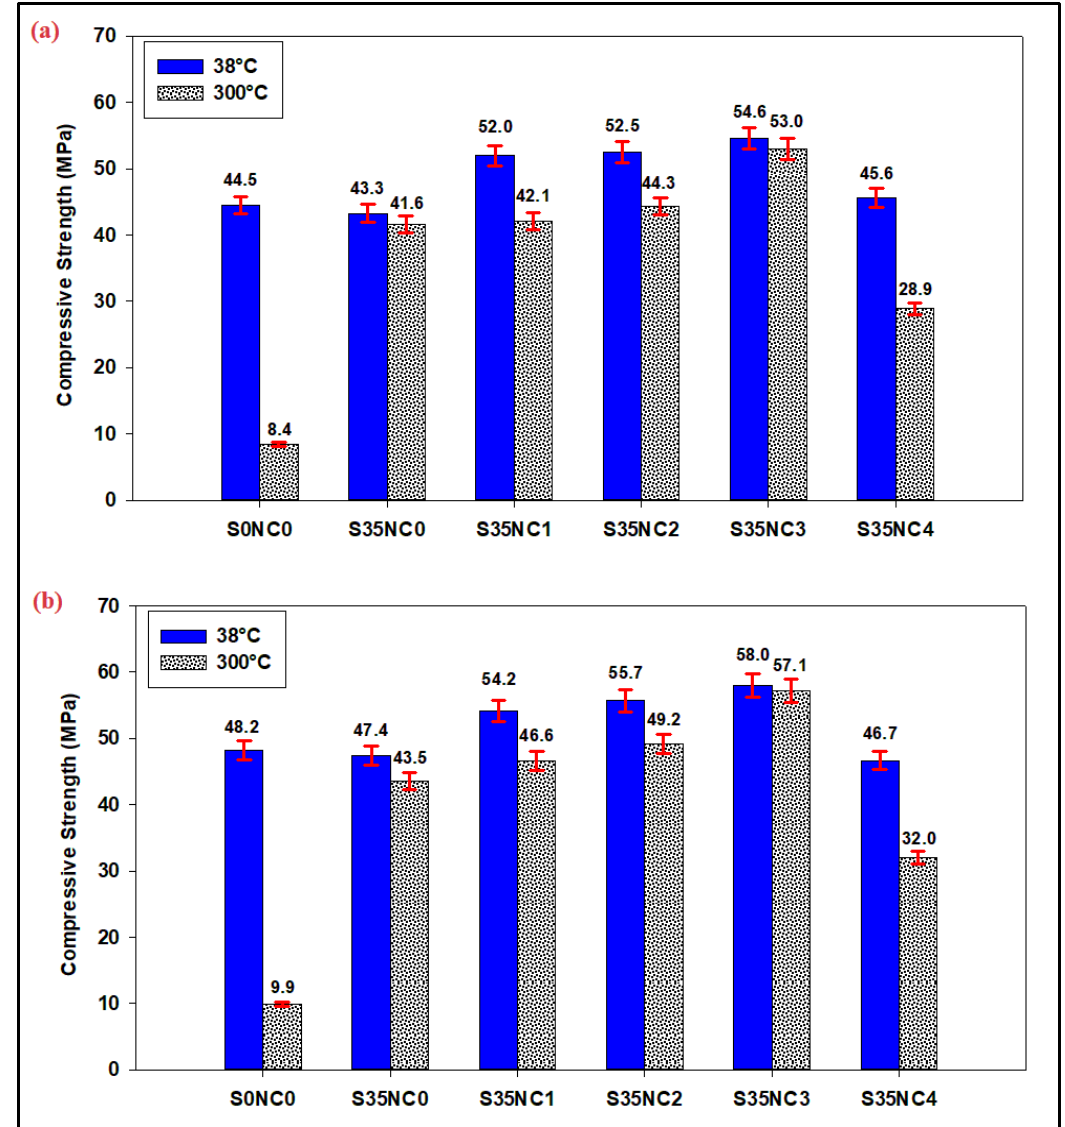
Figure 3. The compressive strength of the samples cured at 38 °C and 300 °C after ( a ) 7 days ( b ) 28